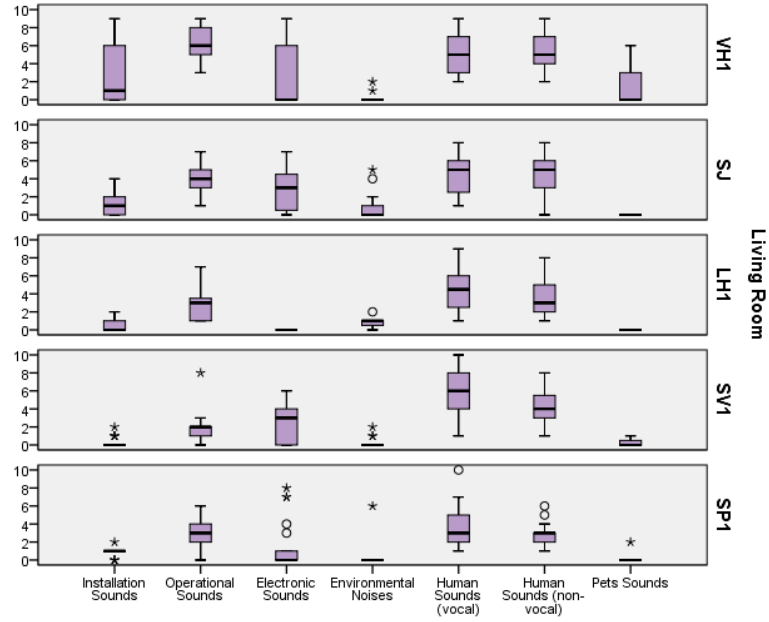
Figure 14. Distributions of Q3 scores for its seven items, sorted by living room.